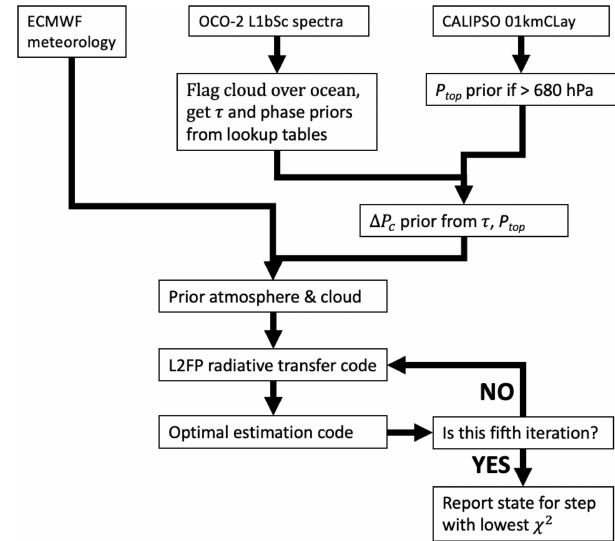
Figure 3. Flow diagram illustrating the OCO2CLD-LIDAR-AUX